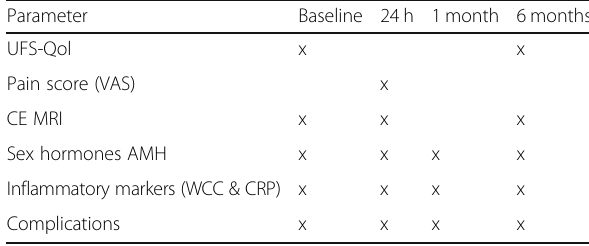
Table 1 Time points for all outcome